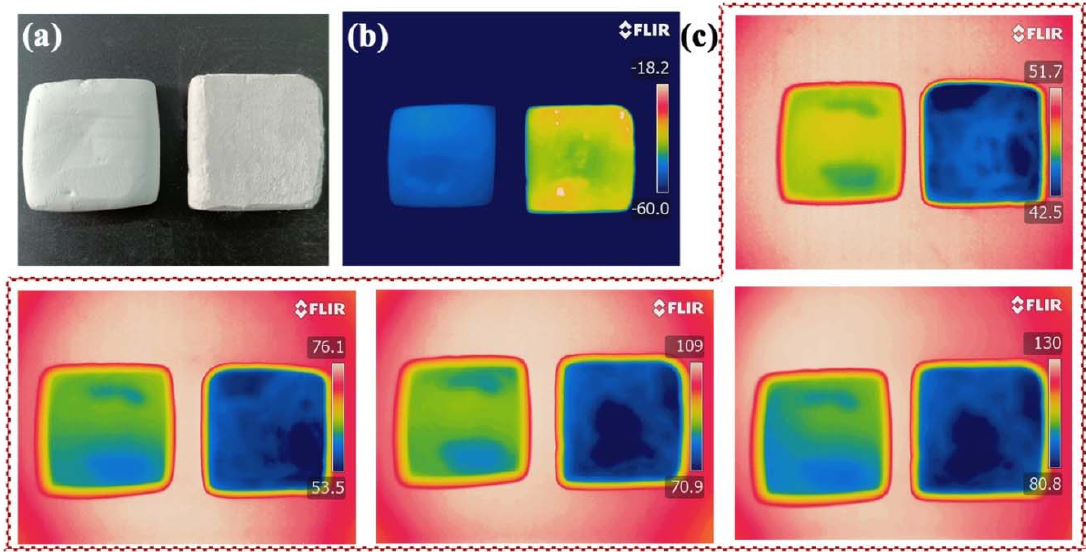
Figure 9. ( a ) Optical photo NPB and PBCS. FLIR images of the NPB and PBCS ( b ) on carbon ice base plate, and ( c ) heating base plates at different temperatures. (The unit of the temperature scale bar on the right of ( b , c ) is °C, and the FLIR images were automatically generated by the FLIR).